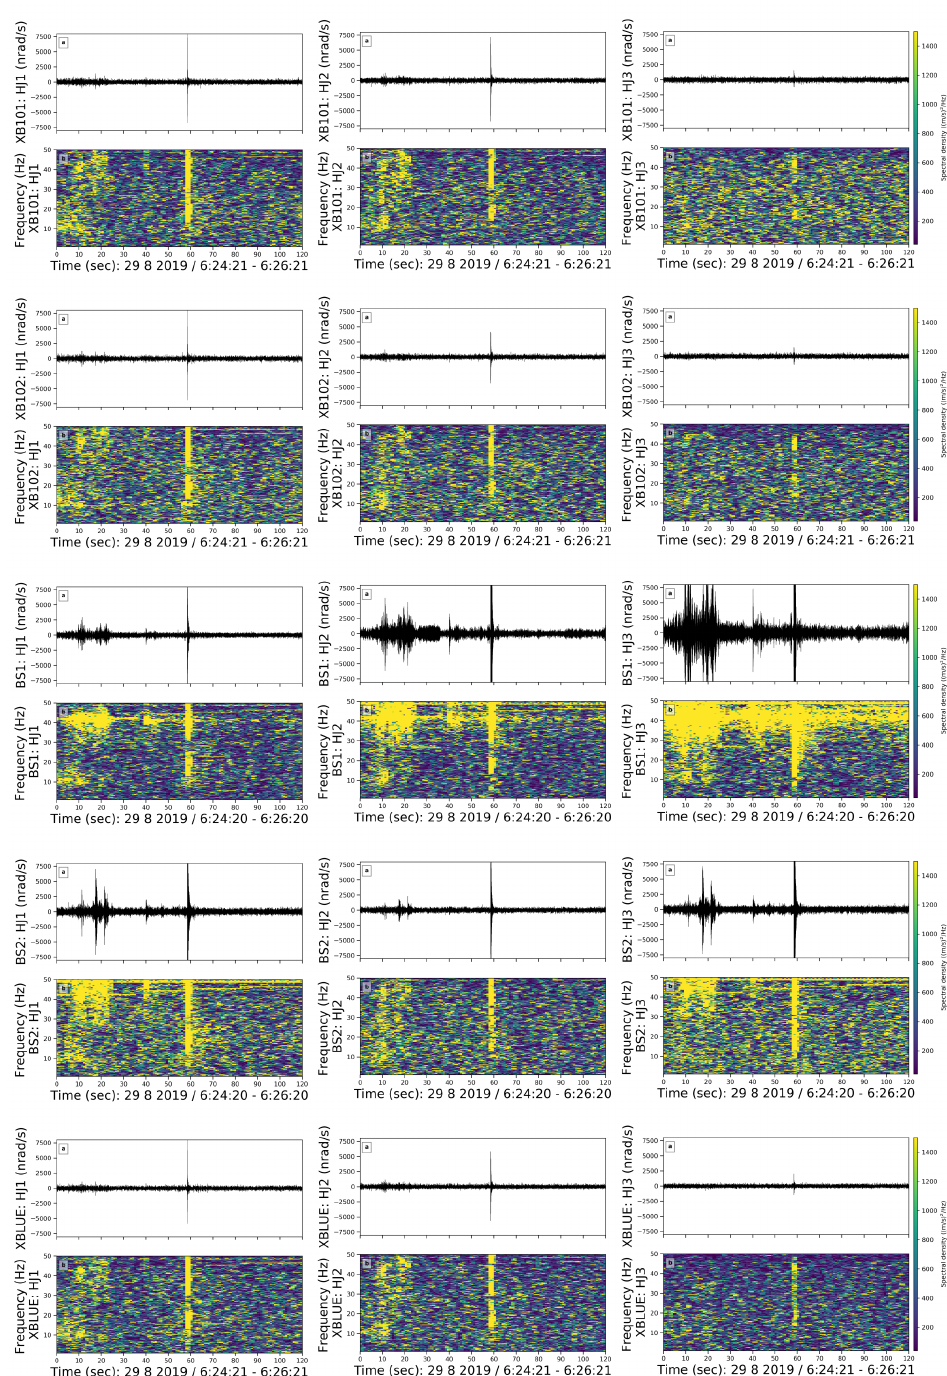
Figure 10. Spike-shaped noise in a broad frequency range in a 2 min long time window on doy 241, i.e., 29 August, Thursday. The subfigures and colors are the same as in Figure 6. To sum up, correlation of the waveforms from rotational and translational sensors over a 24 h time frame is estimated in this section. The results show similar values and a positive correlation in time. When the correlation of each sensor is investigated within a specific time window that includes a coherent noise (e.g., in Section 4.3), it shows high correlation results in comparison to the 24 h long